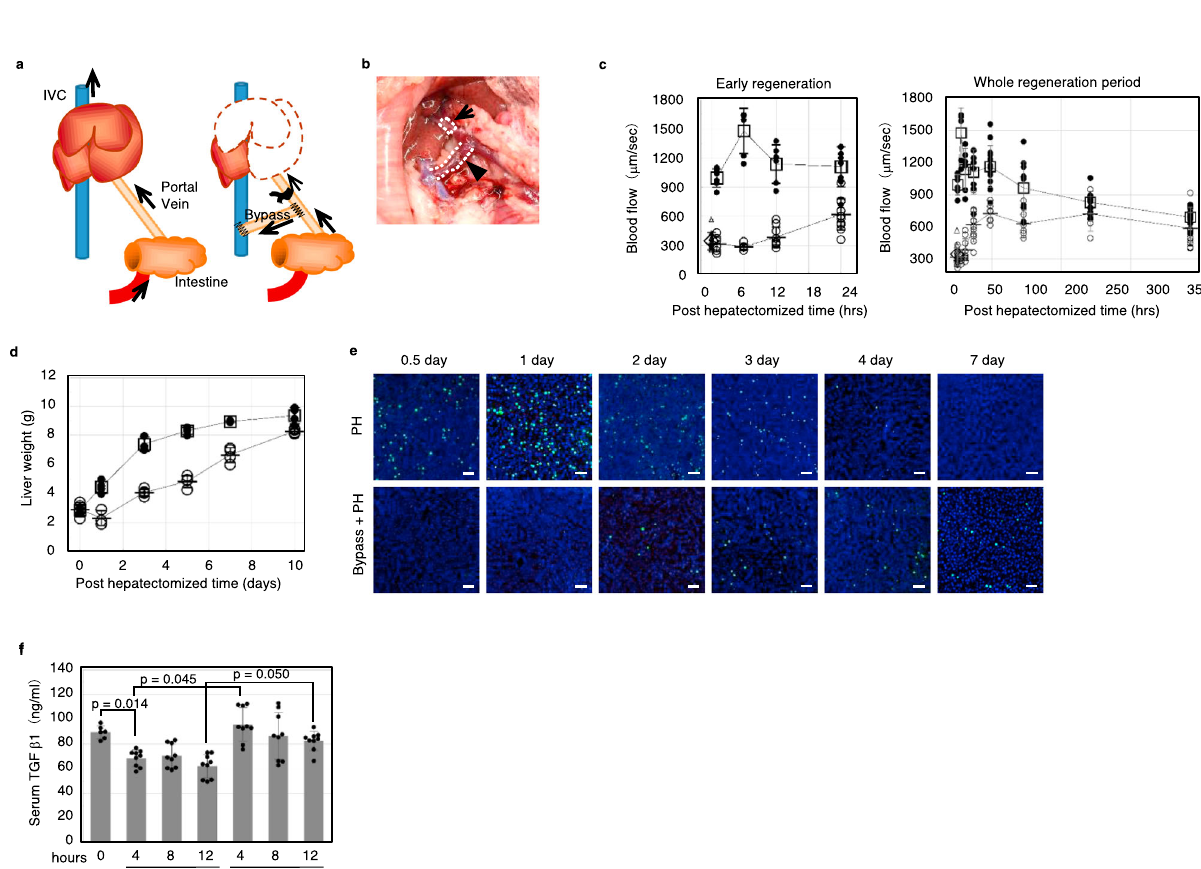
Fig. 2 Dynamic alteration of sinusoidal structure during liver regeneration. a Hypothesis for the effect of PH on sinusoidal fl ow velocity. Total blood volume ( Q ) split to each lobe as Q 1 (LL), Q 2 (LML), Q 3 (RML), Q 4 (RL), and Q 5 (CL). The relation of each parameter is shown in the fi gure before PH. After PH, the in fl ow volume in the RL and CL increased because Q was unchanged and the sinusoidal fl ow velocity increased to allow blood fl ow. After regeneration, the Q ′ 4 and Q ′ 5 values were unchanged, but the sinusoidal fl ow velocity decreased because the liver volume increased. b Analysis of liver weight during regeneration after PH ( n = 5 for each time point). The white square represents the liver weight before PH. c Histological analysis of the regenerating liver: HE image (top), angiographic image using FITC-gelatine (bottom, green: sinusoid loaded with loaded FITC-gelatine, blue: nucleus. Scale bar, 20 μ m). d Image extraction for sinusoids and cellular nuclei for statistical analysis. e Quantitative analysis of sinusoidal structure in the regenerating liver: surface area of vessels (top left, n = 5 for each time point), vessel volume (top right, n = 5 for each time point), interior angle of branch (bottom left, n = 6 for 0 and 120 h and n = 7 for 24 and 72 h), and number of cells (bottom right, n = 6 area for each time point). Data are presented as the mean ± SD. The p -value is a comparison with 0 h. f Image of moving erythrocytes that were analysed using a fl uorescence microscope and a high-speed camera every 0.04 s. g Blood fl ow rate in sinusoids during liver regeneration. The white square represents the sinusoidal fl ow rate before PH ( n = 5 for 0 and 24 h and n = 6 for 12, 72, 120, 168, and 240 h). Data are presented as the mean ± SD. The p -value is a comparison with 0 h. The white square represents the liver weight before PH.